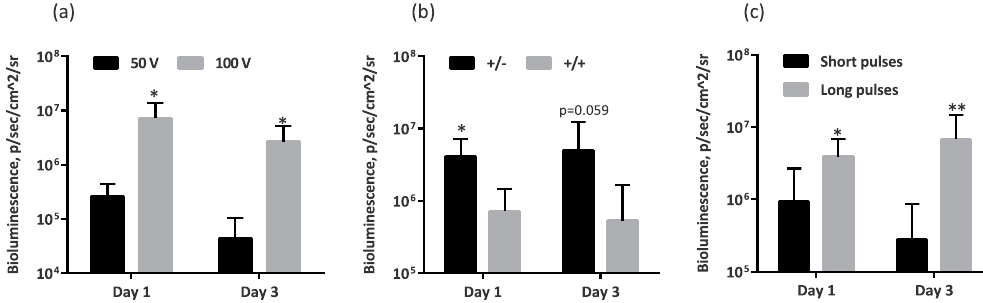
Figure 6. Evaluation of the driving pulse voltage ( a ) polarity ( b ) and duration ( c ) effects on the delivery/ expression of the luciferase reporter gene. BALB/c mice (n = 4–8) were intradermally injected with 20 µ g pVaxLuc (per site) into two sites, and injections were followed by electroporation with a BEX machine equipped with multi-needle electrodes (CUY691-5, BEX Ltd). Electroporation was initiated with a poration pulse of 400 V of 0.05 ms followed by a train of eight 50 V ( a – c ) or 100 V ( a ) pulses of the same ( + / + ; a – c ) or opposing/ alternating polarity ( + / − ; b , c ) administered for 10 ms (Short pulses; a – c ) or 50 ms (Long pulses; b , c ) with 20 ms (Short pulses) or 950 ms (Long pulses) intervals. Bioluminescence was registered by in vivo imaging on day 1 and 3 after the injections. Data represent the average photon flux from all injections sites in the group (photons/s/cm 2 /sr), and the error bars represent the SD. All assays were performed in duplicate. * p < 0.05, ** p < 0.01; p-values in the interval 0.05 to 0.1 indicate tendencies. Statistical comparisons were performed using Mann–Whitney